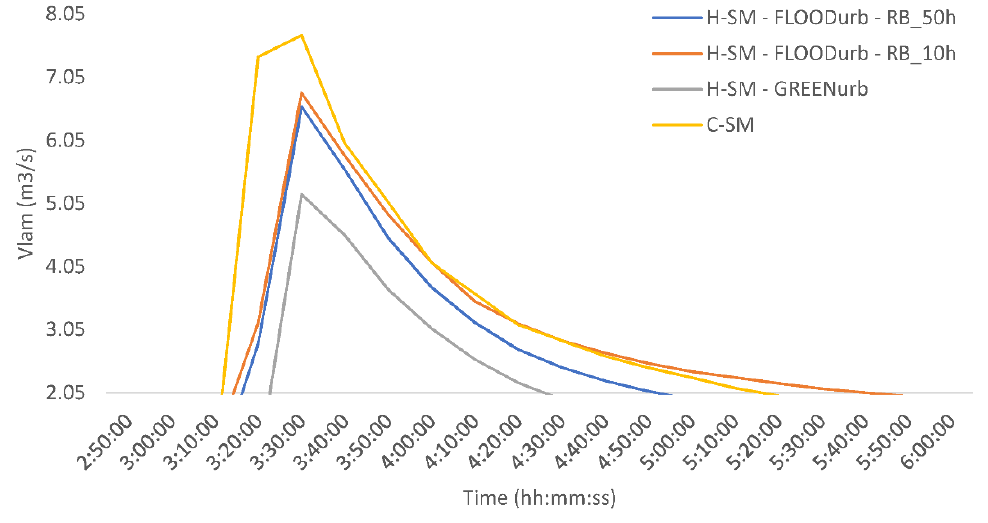
Figure 6. Over threshold volumes (Vlam) CSO 1019 (Catchment A) under 10-year rainfall event.